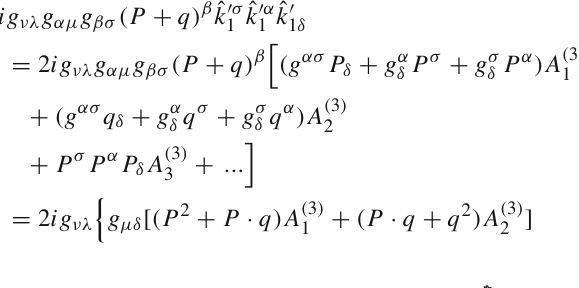
Table 1 Numerical results of form factor T 3 ( q 2 ⊥ ) at q 2 ⊥ = ( 0 , 1 , 4 , 9 ) GeV 2 for B c → D ∗ B c → D ∗